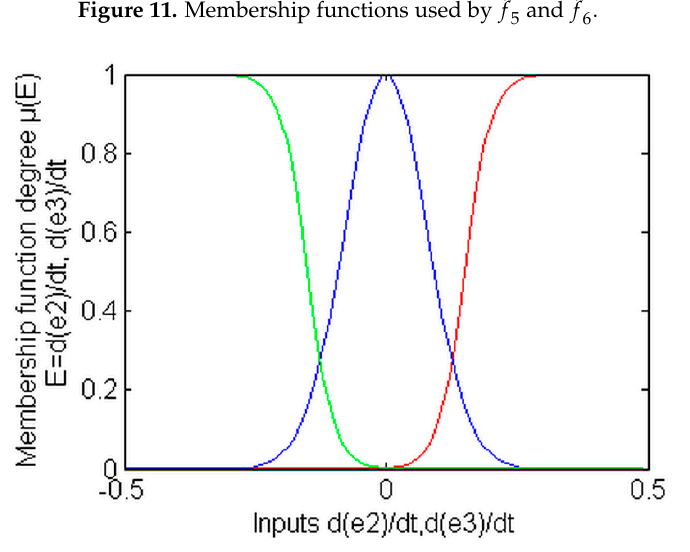
ˆ f ˆ f . and 4 ˆ f ˆ f . and ˆ f . and 4 3 4